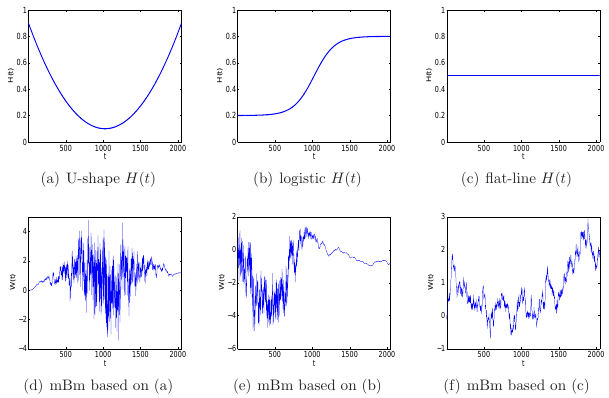
Figure 1: Tested H ( t ) functions, (a) U-shape , (b) logistic , and (c) flat-line , are Fig. 1. Tested H(t) functions, (a) U-shape , (b) logistic , and (c) flat- shown in the upper row. The corresponding simulated mBm signals with C = 3 line , are shown in the upper row. The corresponding simulated mBm are shown in the lower row. signals with C = 3 are shown in the lower